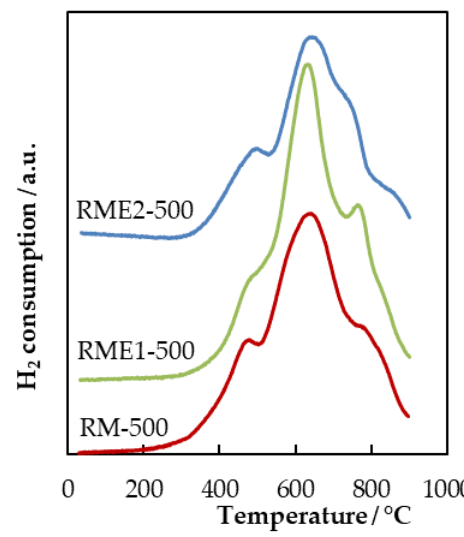
Figure 5. H 2 -TPR profiles obtained for the RM and RME samples.